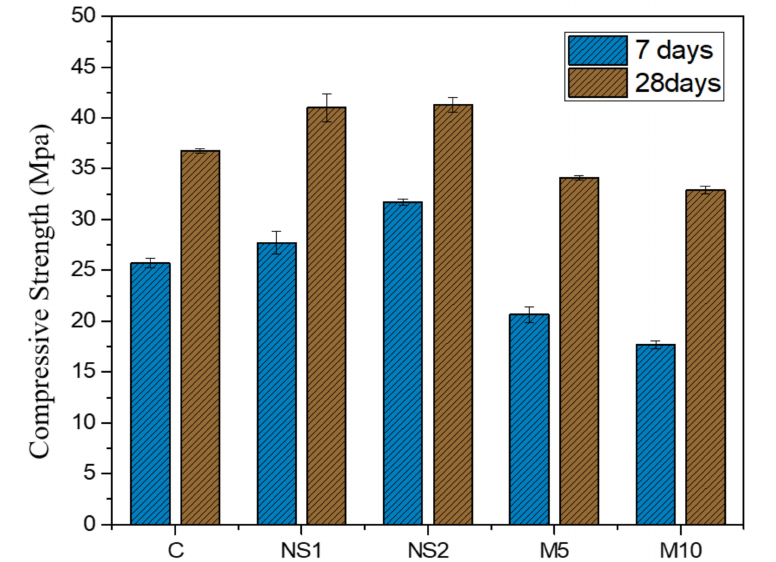
Figure 6. Compressive strength results of UWC concrete specimens with different amounts of NS and MgO after 7- and 28-day curing.